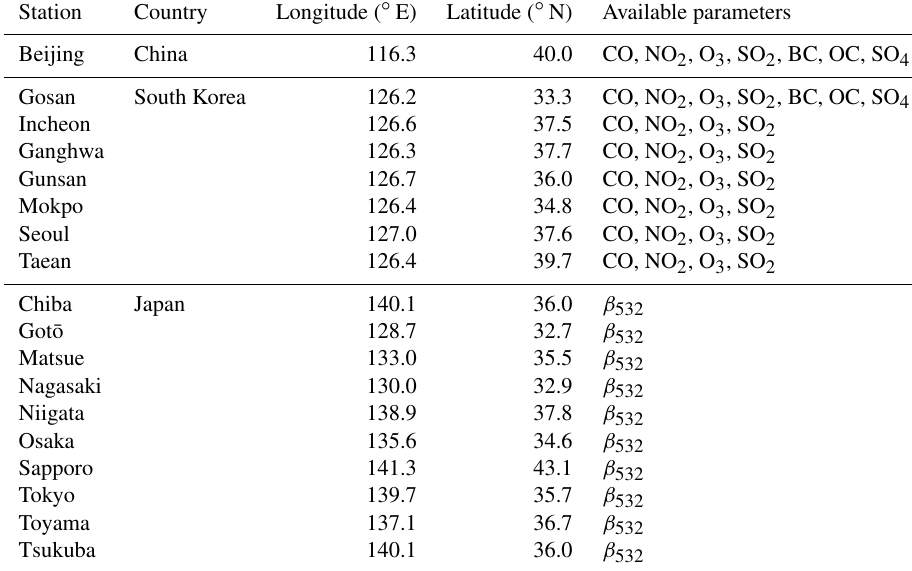
Table 2. Coordinates of stations used in this study and available parameters.